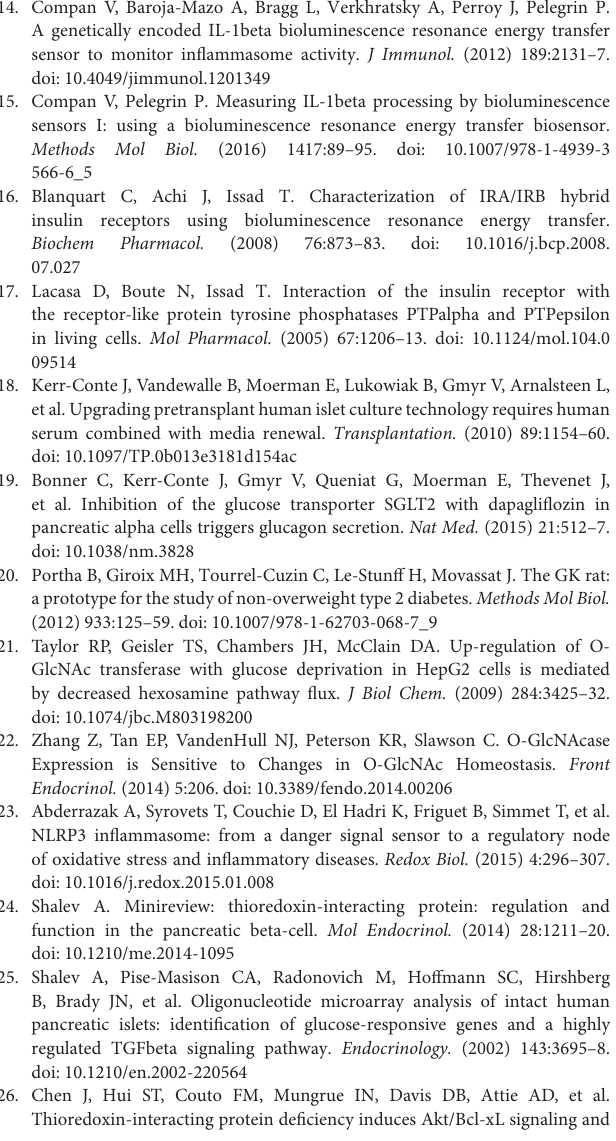
Supplementary Figure 1 | Transcriptional regulation of the Txnip promoter in response to glucose and OGA expression (A) . Schematic representation of the Txnip promoter (1081 base pairs; the two ChREBP binding sites (ChoRE) and the FoxO1 binding site (IRE) are indicated). (B) INS1 832/13 cells were infected by GFP or OGA adenovirus for 24h. INS1 832/13 cells were then stimulated for 24h under low glucose (2.5mM) or high glucose (20mM) concentrations. Luciferase activity of the Txnip promoter was measured. Figure is presented as means ± SEM from 3 to 4 independent cultures. Significance is based on two-way ANOVA followed by a Bonferroni post-hoc test. ∗∗ p < 0.01 when compared to GFP conditions, ∗∗∗ p < 0.005 when compared to 5mM glucose condition (GFP), $$ p < 0.01 when compared to 20mM glucose condition (GFP). Supplemental Figure 2 | INS1 832/13 cells were transfected with a BRET-based biosensor that monitors pro-Il1 β cleavage. The histogram shows the decreased in BRET signal measured in INS1 832/13 cells after 24h of incubation with PUGNAc (100 µ M) or with ThiametG (10 µ M). Significance is based on two-way ANOVA followed by a Dunnett’s test for BRET experiments. ∗∗ p < 0.01 ( n =